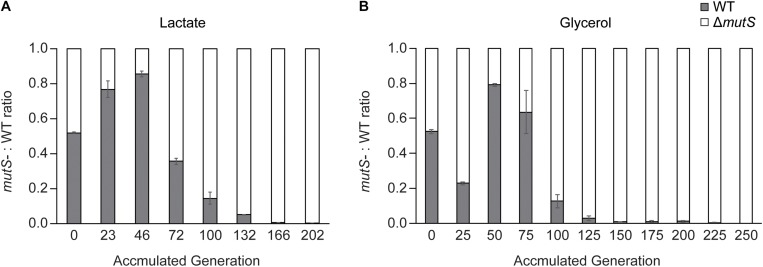
Competition experiment between E. coli parental wild-type and ΔmutS strains. Ratio-wise representation of the proportion of the parental wild-type versus the parental ΔmutS strains in the course of competition experiment in (A) lactate or (B) glycerol minimal medium. Each bar represents the ΔmutS/wild-type ratios from the propagating cultures sampled intermittently.